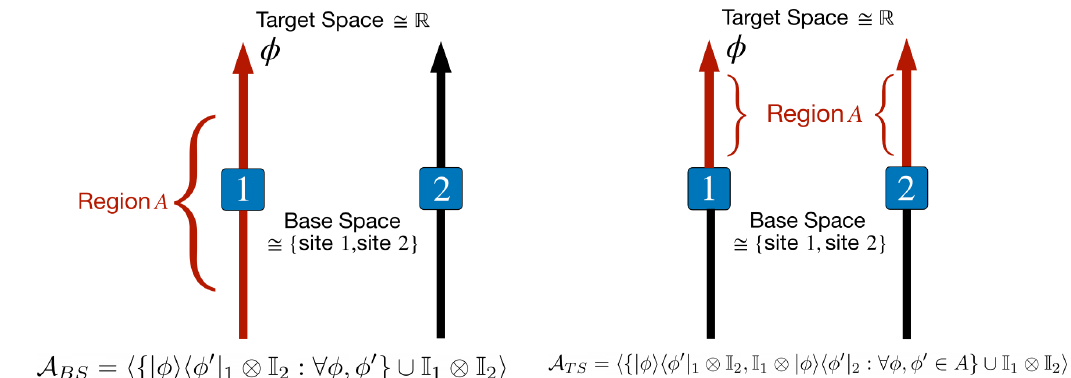
Figure 4 . Base (left) vs. Target (right) Space Partition & Associated Algebras for scalar field on two lattice